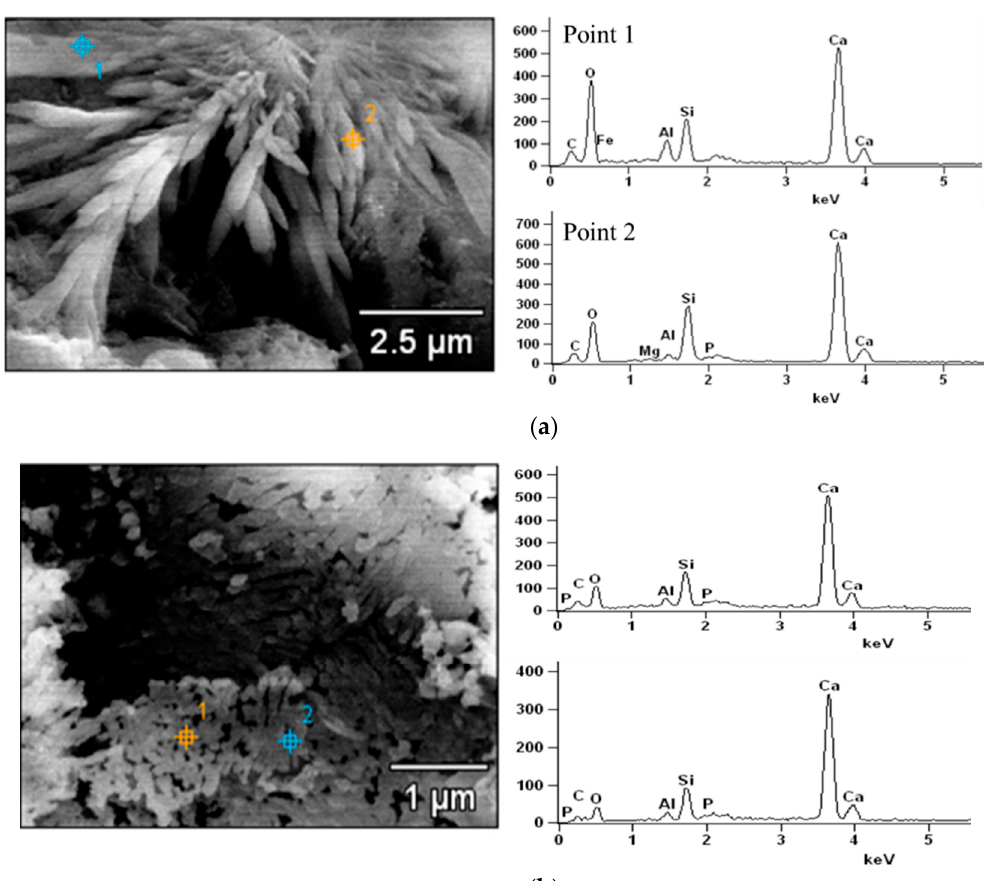
Figure 11. SEM-EDX analysis of hydration products of C-S-H with phosphorous. ( a ) 2.0%P 2 O 5 and ( b ) 2.5%P 2 O 5 Table 4. chemical composition of C-S-H in cement pastes with 2.0% and 2.5% P 2 O 5 by EDX / wt.%.